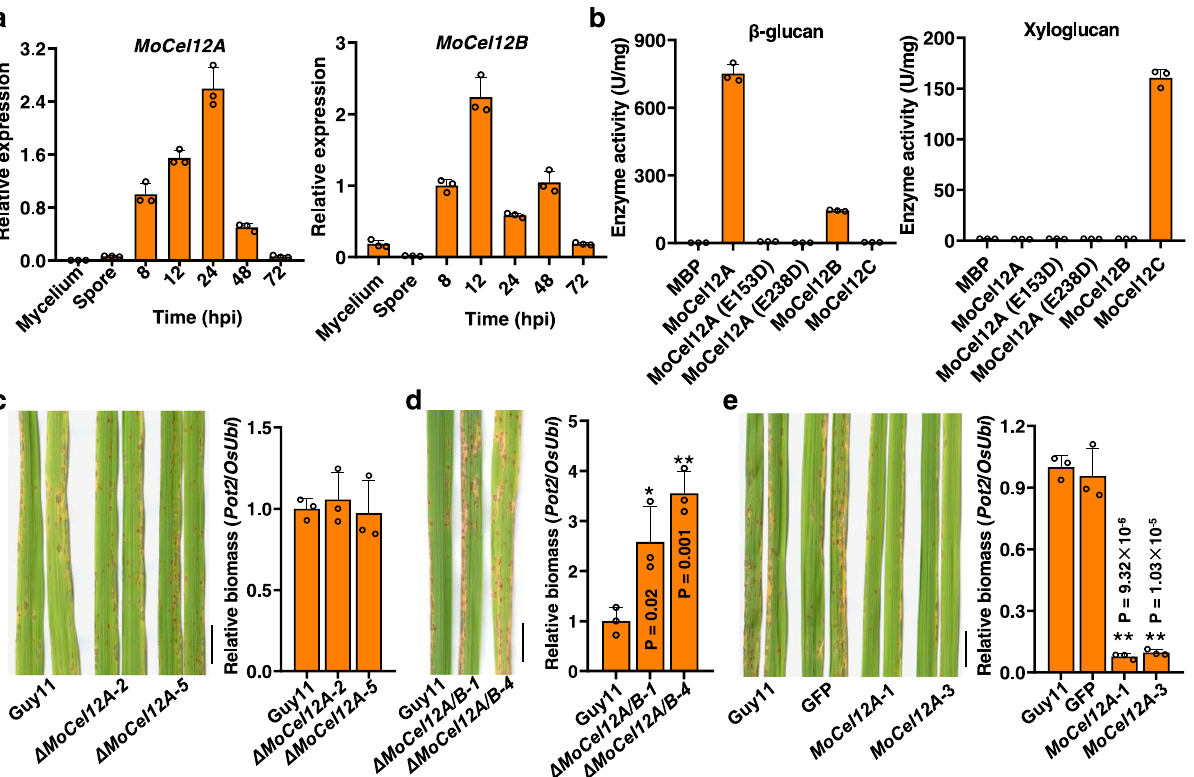
Fig. 1 MoCel12A/B are required for the pathogenesis of M. oryzae . a MoCel12A and MoCel12B transcription levels in different tissue or during M. oryzae infection in rice. The fungi were grown in CM media, and the mycelium and spores were collected for RT-qPCR assays. The rice leaves were inoculated with M. oryzae spores at a concentration of 1×10 5 per ml. The leaves were sampled at indicated time points for RT-qPCR assays. The M. oryzae MoActin was used as a reference gene. hpi, hours post inoculation. Values are means±SD ( n = 3 biological replicates). b The hydrolytic activity on β -glucan (left panel) and xyloglucan (right panel) of recombinant MoCel12 endoglucanases. MoCel12A (E153D) and MoCel12A (E238D) are the mutated MoCel12A. c Knocking out of MoCel12A did not impair the virulence of M. oryzae . Left, disease symptoms of rice leaves infected with Guy11 and two Δ MoCel12A mutants. Conidial suspensions (1×10 5 conidia per ml in 0.02% Tween-20) were sprayed onto the leaf surfaces of 2-week-old rice seedlings. Images were taken at 5 dpi. Bar = 1cm. Right, the relative fungal biomass was determined by qPCR for the M. oryzae Pot2 gene against rice OsUbi gene. Values are means±SD ( n = 3 biological replicates). d M. oryzae Δ MoCel12A/B double mutant exhibited enhanced virulence on rice. Left, disease symptoms of rice leaves infected with Guy11 and two Δ MoCel12A/B mutants. Right, relative fungal biomass. Others are as in ( c ). e Overexpression of MoCel12A in M. oryzae reduced the virulence on rice. Left, disease symptoms of rice leaves infected with Guy11, Guy11-GFP, and two independent MoCel12A overexpression strains. Right, relative fungal biomass. Others are as in ( c ). * and ** indicate signi fi cant differences from the treatment of Guy11 at P <0.05 and 0.01, respectively (two-sided Student ’ s t